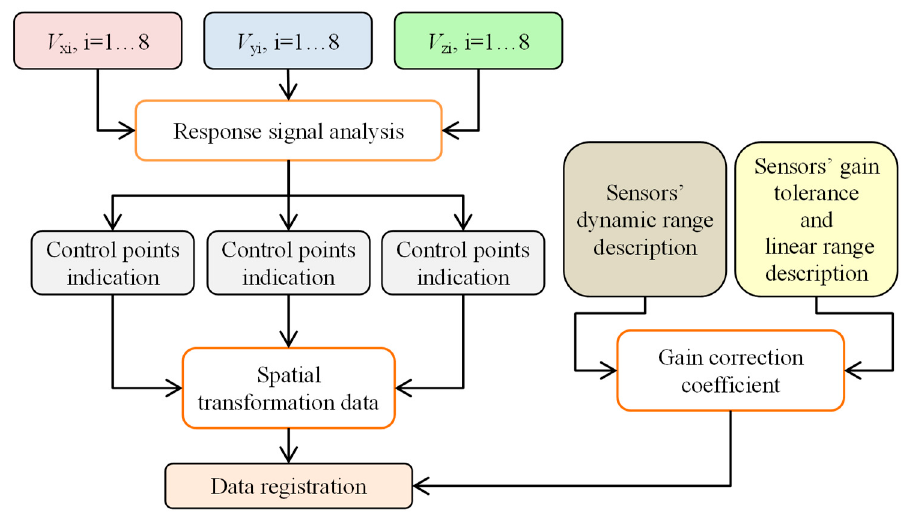
Figure 6. The block diagram of the data registration process.